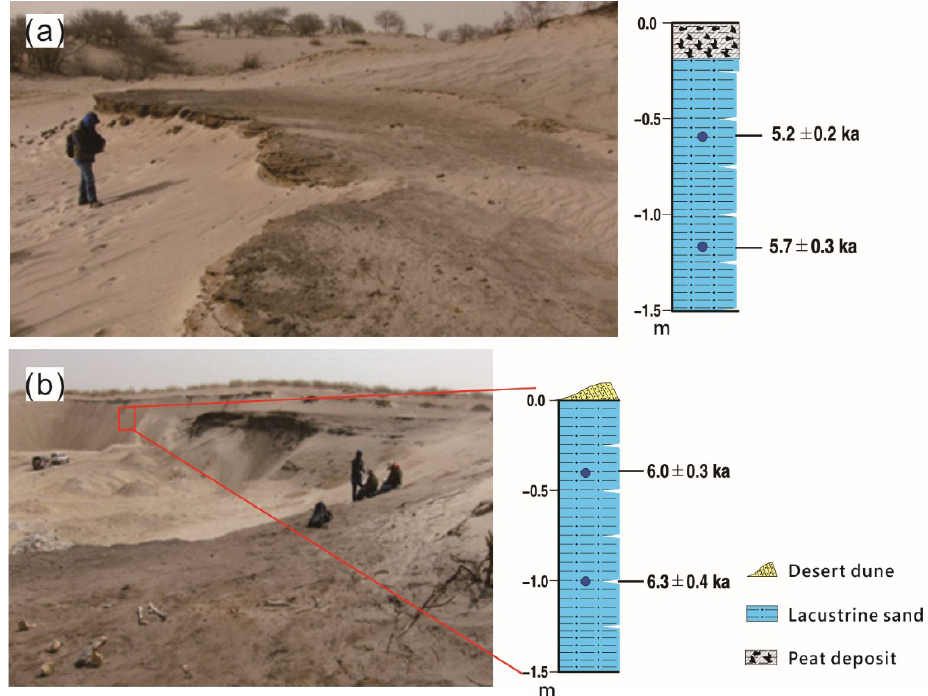
Figure 3. Eastern Hunshandake lacustrine deposits capped by paleosols. (a) Eastern Hunshandake paleosol/lakeshore (Section I from Yang et al., 2015). (b) Bronze age burial (lower left) on the surface of the lake shore exposed by deflation (Section E from Yang et al., 2015).